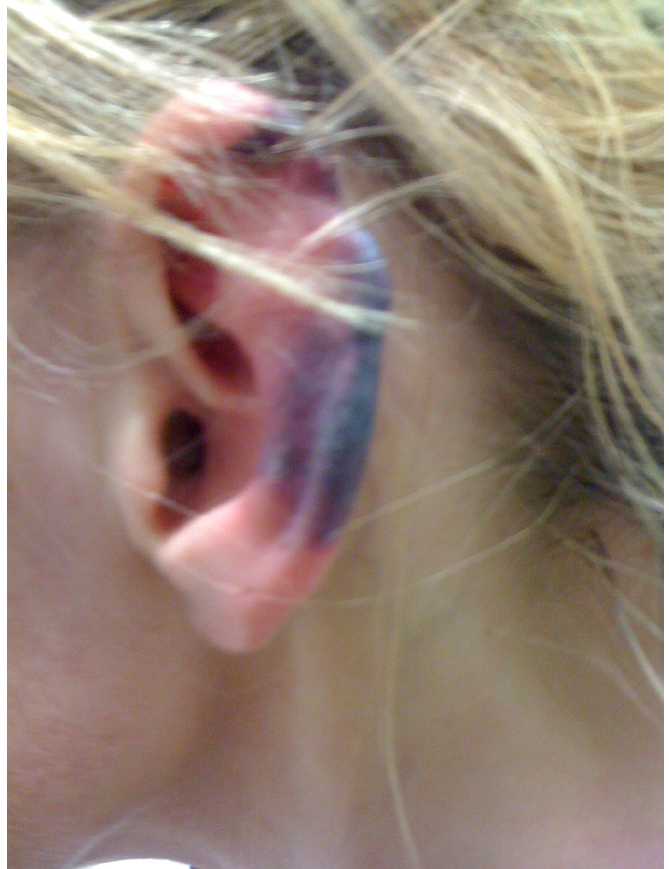
Figure 1. Retiform purpuric skin lesions with eschar on